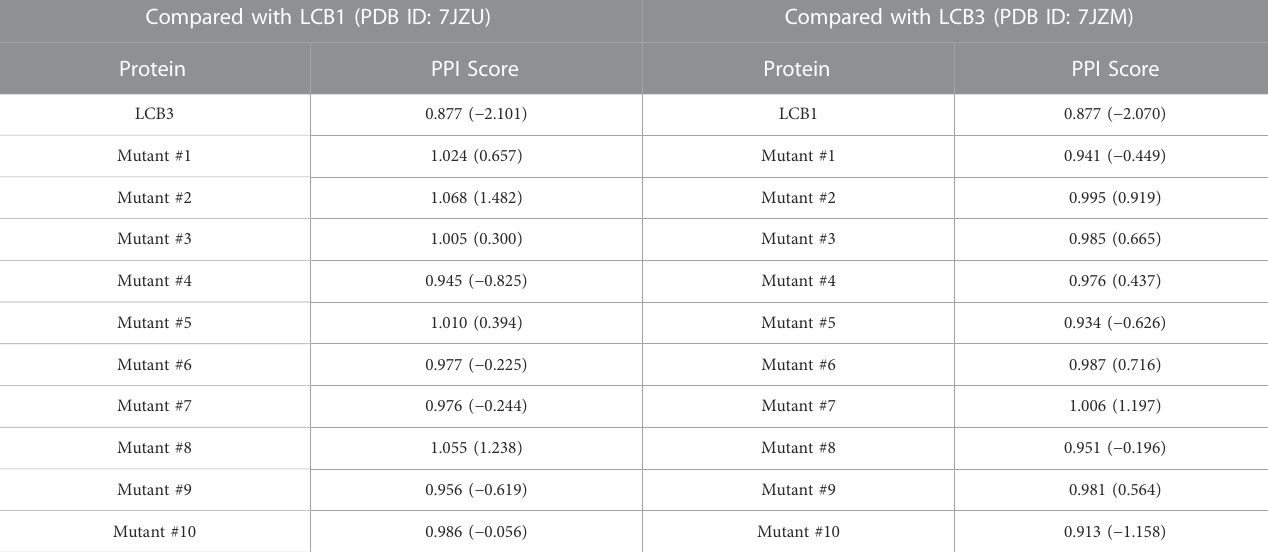
TABLE 3 PPI Scores between ACE2 binders, LCB1, LCB2 and their mutants (decoys). The numbers in the parentheses are Z-Scores. Compared with LCB1 (PDB ID: 7JZU) Compared with LCB3 (PDB ID: 7JZM)